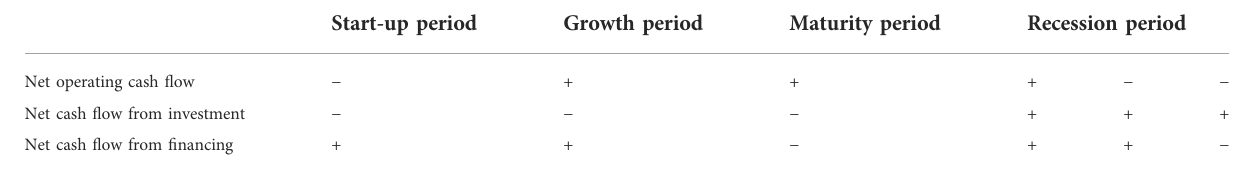
TABLE 1 Division method of enterprise life cycle.